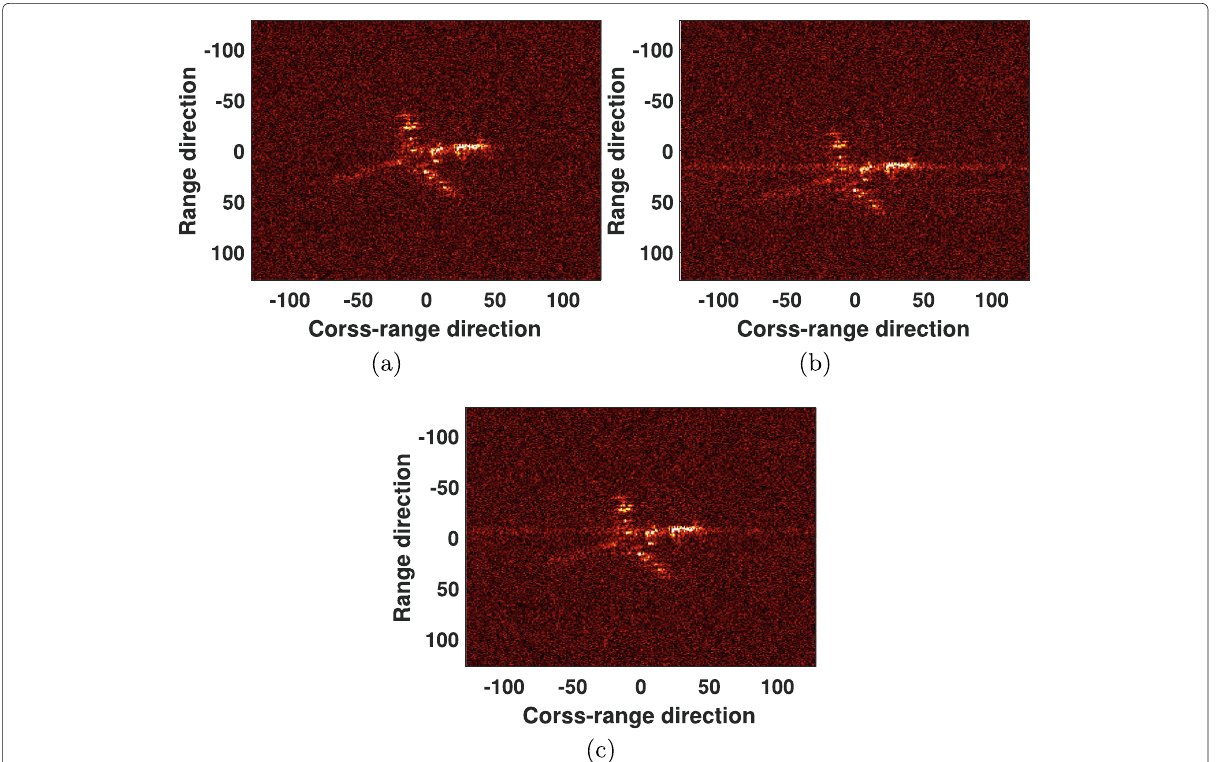
Fig. 12 Imaging results under a − 22 dB SNR. a The imaging result of the proposed algorithm, b the imaging result of the ACM, and c the imaging result of the